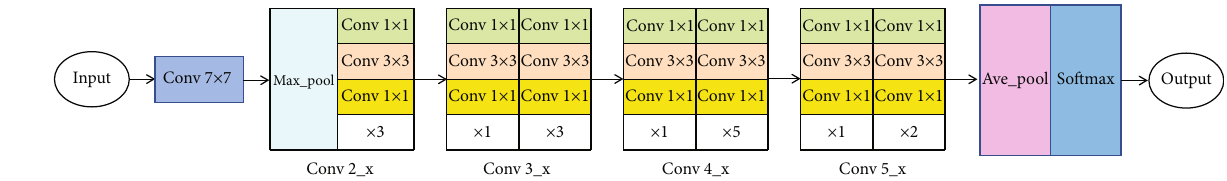
Figure 3: Detection fl ow chart.